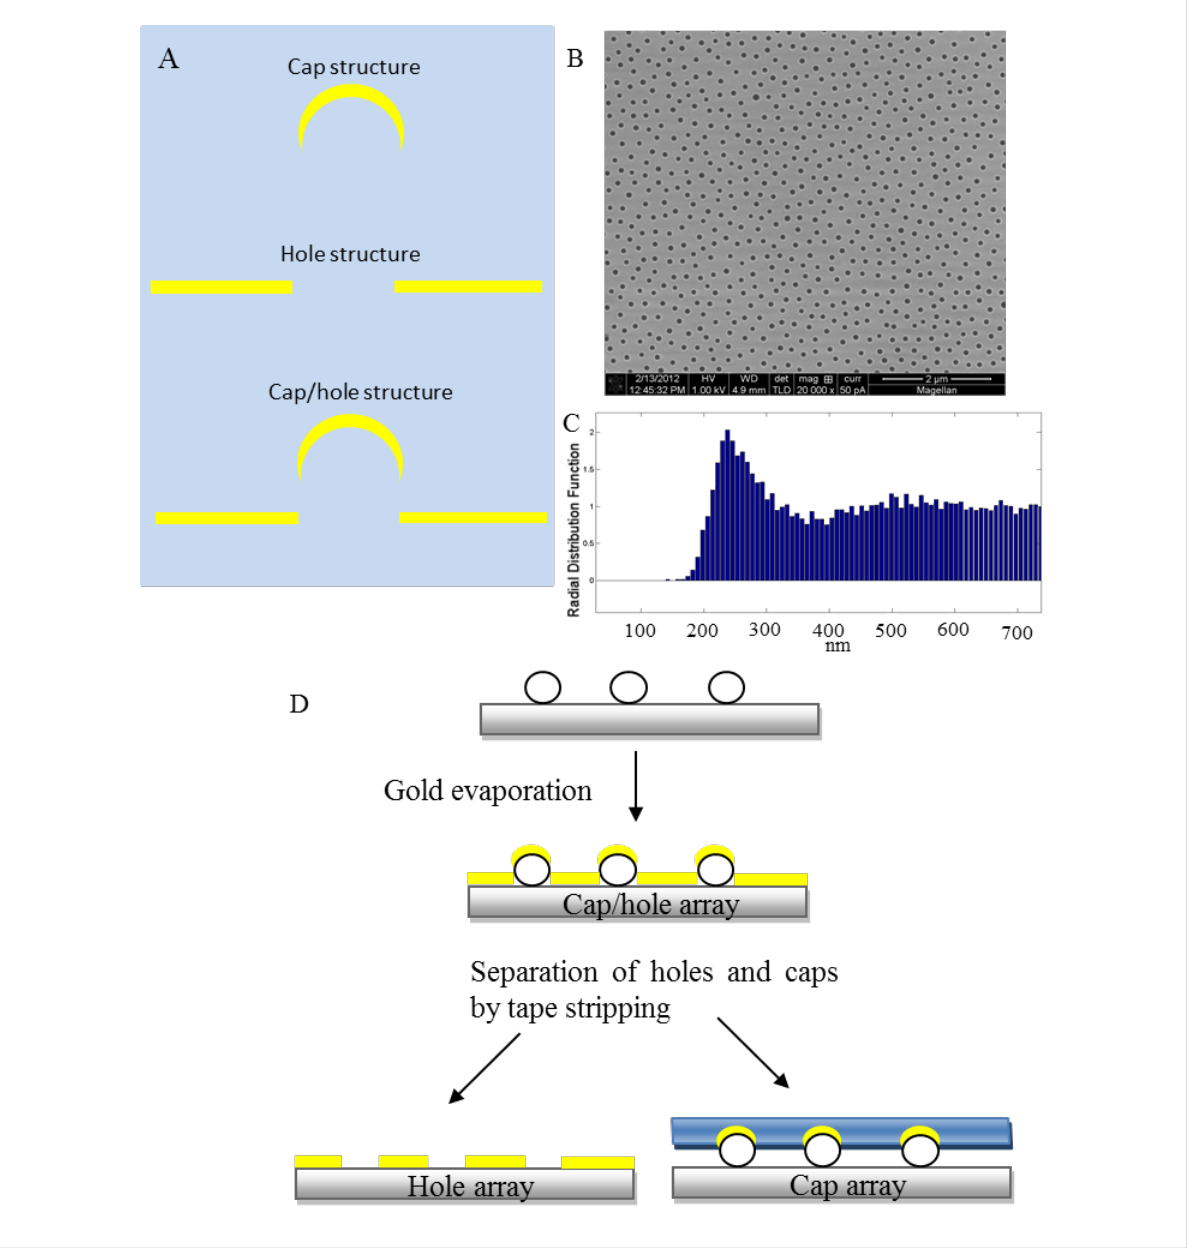
Figure 1: A) Schematic of the design of the plasmonic gold structures fabricated by colloidal lithography. B) SEM image showing the distribution of a 110 nm hole array in 20 nm thin Au film after removal of the gold-caps by tape stripping. C) Radial distribution function showing the characteristic average spacing between holes of the same hole array. D) Fabrication route for the plasmonic structures.